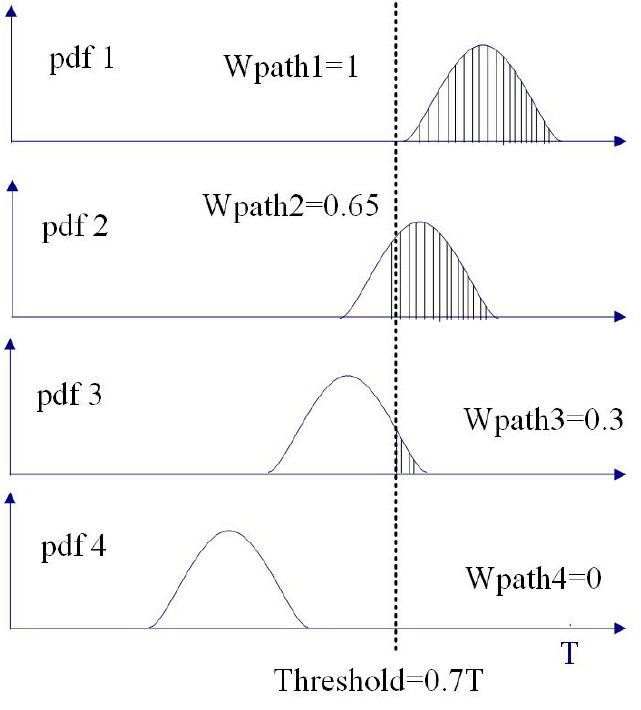
Figure 7. Example of path weight assignment [21] for the pdf of different path